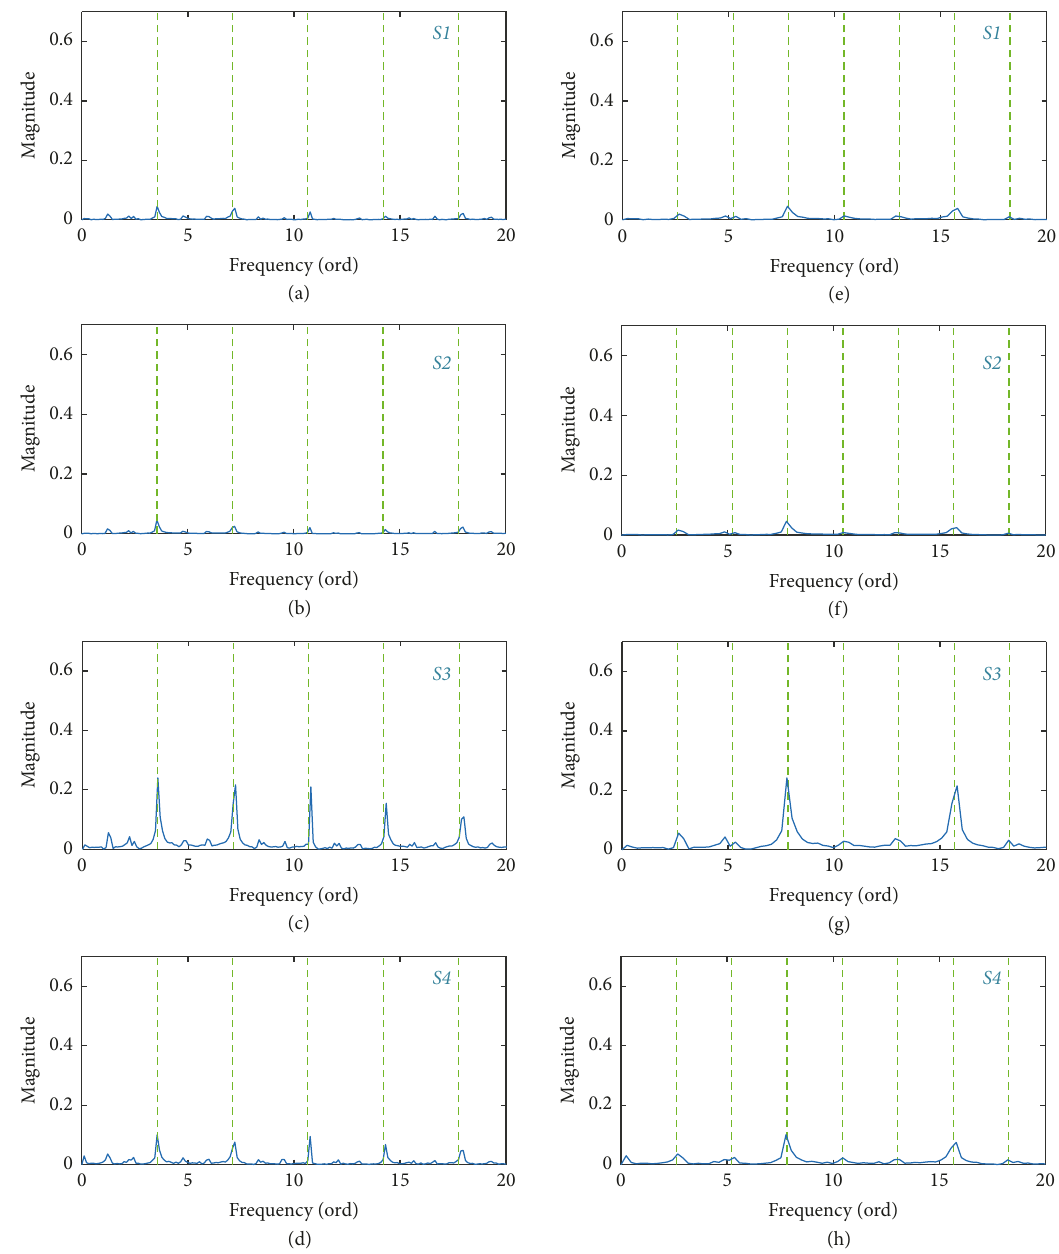
Figure 11: Envelope order spectrums for B1 (a–d) and for B3 (e–h) for the time domain signals in Figure 10, respectively, from (a) to (d).